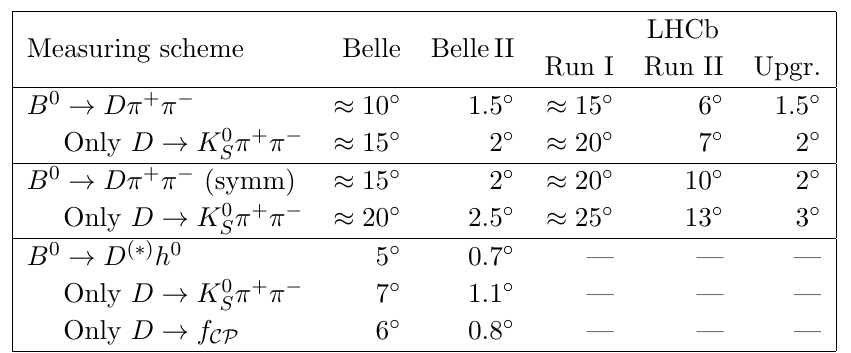
Table 3 . Estimates of the angle (cid:12) measurement statistical precision for the three schemes with the input value (cid:12) = 22 (cid:14)